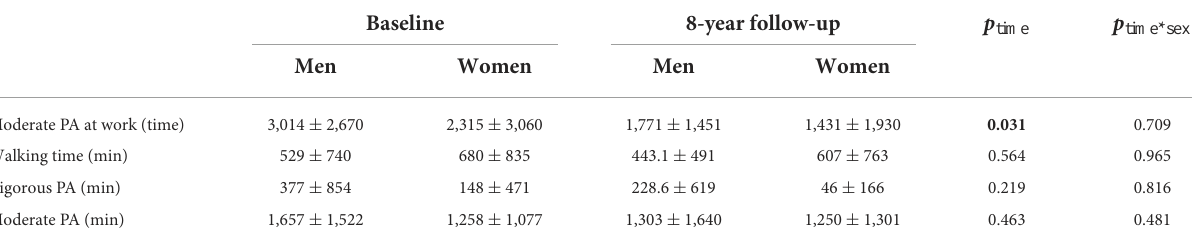
TABLE 4 Self-reported physical activity (PA) of different levels of intensity for men and women at the baseline and in follow-up measurements.